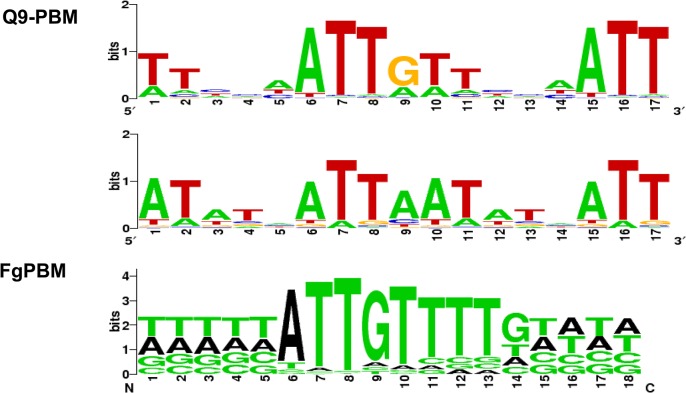
The determined consensus binding sequences according to two PBM analyses (Q9-PBM and FgPBM).The target probes in Q9-PBM (Quadruple 9-mer-Based PBM) are synthesized as quadruples of all possible 9-mer combinations, whereas FgPBM consists of probes designed from the putative promoter region (1,000 bp upstream of the start site of each ORF) of the F. graminearum genome (refer to S2 Text for details). To determine the binding motifs, two independent linear models were applied in the deep and heavy right tail region (refer to S2 Text and S7 Fig). Here, two of the most significant binding motifs identified by Q9-PBM are shown, among which the ATTGTT motif was also identified by FgPBM.